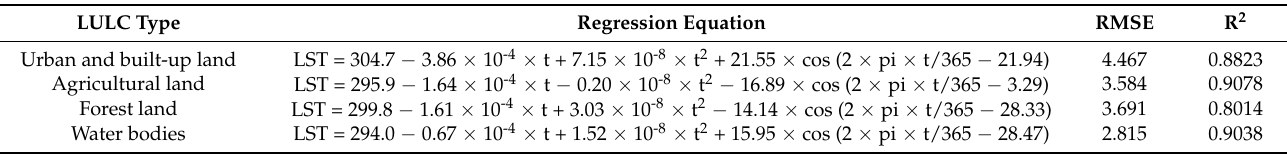
Table 7. LST regression equation for LST modeling using non-linear trend component and seasonality component.